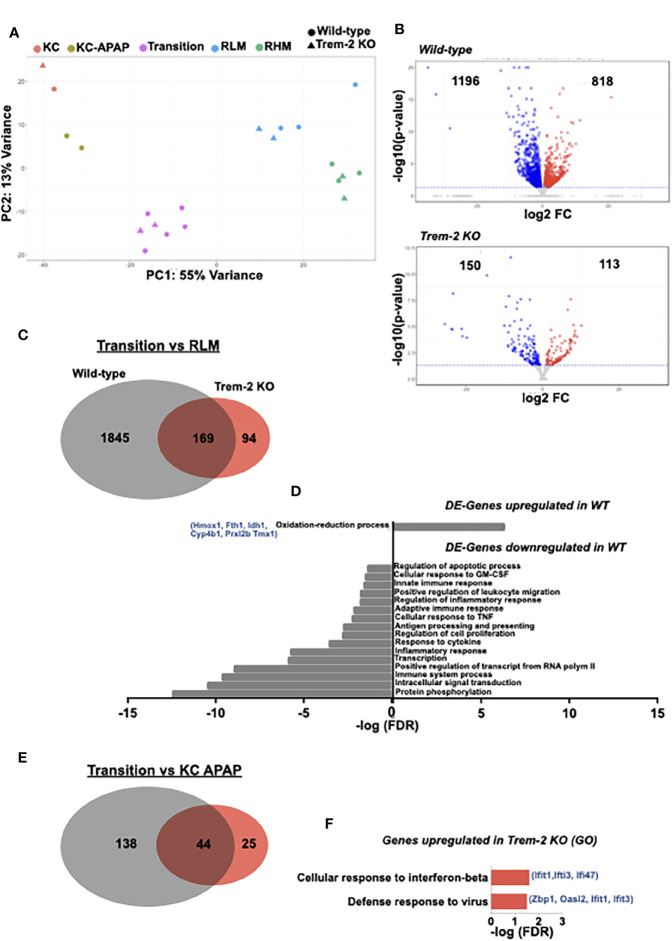
Transcriptomic profiling identifies a Trem-2 dependent program in transition macrophages. Principal component analysis (PCA) of transcriptomic data representing clustering of different sort-purified macrophage populations (represented by colors) from wild-type (circles) and Trem-2 KO mice (triangles) (A). Volcano plots representing differential expressed (DE) genes (q<0.05) between transition and recruited-like macrophages (RLM) in wild-type and Trem-2 KO mice. Red dots represent upregulated genes (LogFC>0), while blue dots represent downregulated genes (LogFC<0) (B). Venn diagram representing DE-genes between transition and RLM, which are common to wild-type and Trem-2 KO mice (middle), exclusively detected in wild-type (left) or in Trem-2 KO (right) (C). Gene Ontology (GO) enrichment analysis in the “Biological Process” category for DE-genes upregulated or downregulated in transition versus RLM in wild-type mice (D). Venn diagram representing DE-genes upregulated in transition macrophages versus Kupffer cells (KC APAP-D3) in wild-type and Trem-2 KO mice (E). Gene Ontology (GO) enrichment analysis in the “Biological Process” category for DE-genes exclusively upregulated in transition macrophages of Trem-2 KO mice (F). GO terms over-represented for FDR (Bejamini)<0.05.